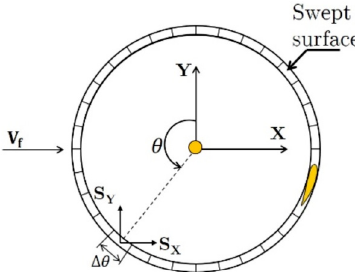
Fig. 7. Schematic view of the discretized swept surface used in the BEM-RANS model. A value of the BEM source term S is computed in each grid